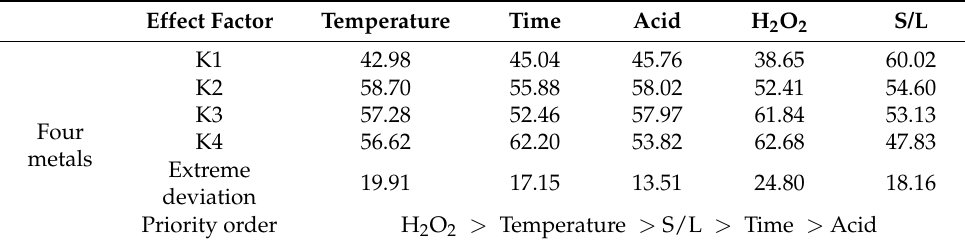
Table 7. Factor response table for four metals in citric acid.